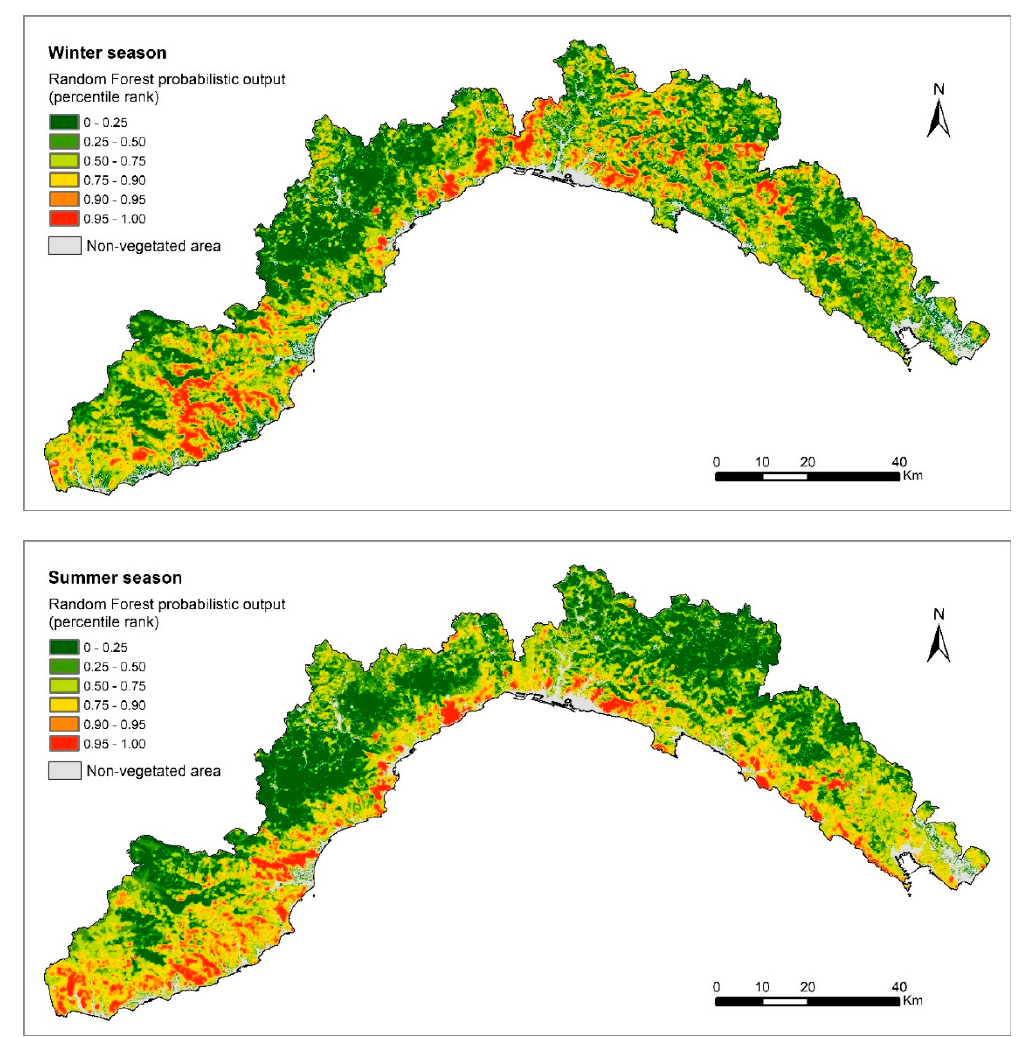
Figure 5. Wildfire susceptibility map in the winter (on the top) and summer seasons (on the bottom) for the Liguria region (Italy).